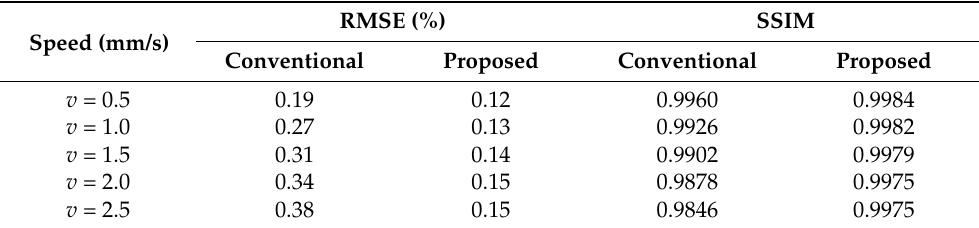
Figure 5. Experimental results of moving phantom. Absorption and scattering property maps of ( a ) the static phantom and ( b ) the phantom at v = 2 mm/s obtained using the conventional single-pixel SFDI (top) and the proposed method (bottom), respectively. ( c ) Absorption maps of the phantom at different speeds. The dashed circles and white arrow indicate the true location and moving direction of the target, respectively. Table 1. SSIM and RMSE of the experimental results.